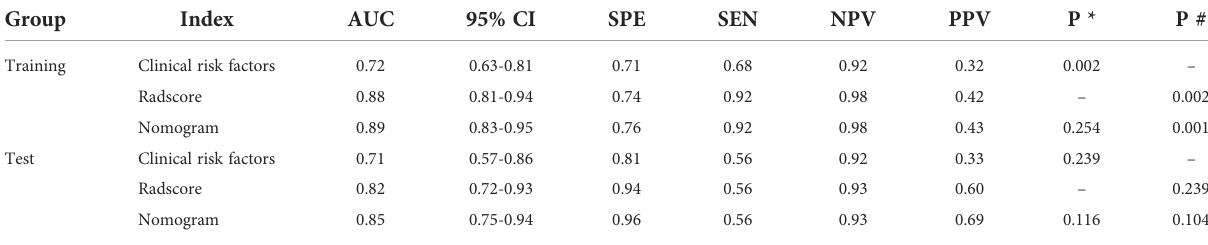
TABLE 2 Diagnostic performance of the clinical risk factors, radscore, and radiomics nomogram in the training and test groups.